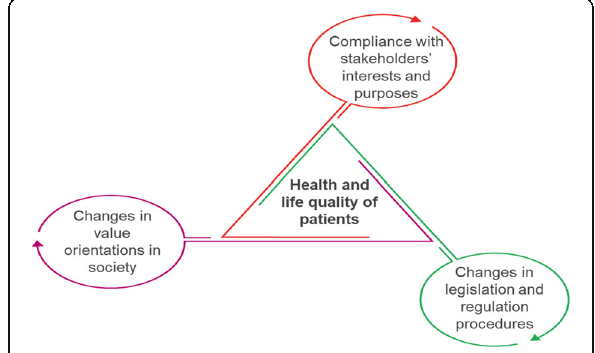
Fig. 8 Holistic approach to full supply of medical cannabis to Ukrainian